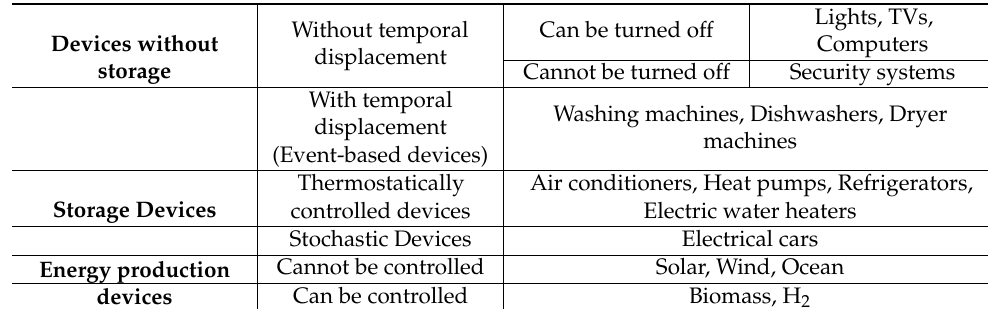
Table 1. Household device